Question: Write the caption for this figure.
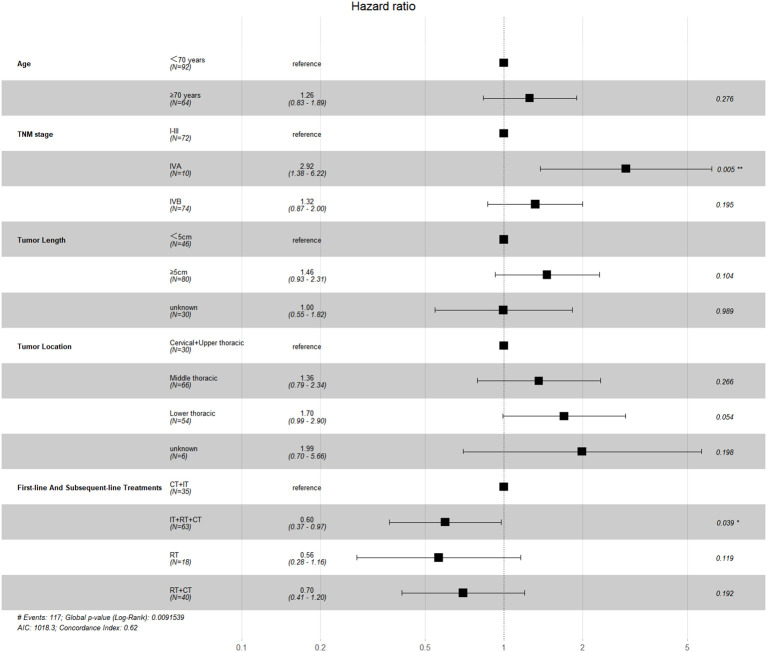
Answer: Multivariate Cox regression analysis for OS of 156 recurrent and/or distant ESCC patients. * P < 0.05, ** P < 0.01.